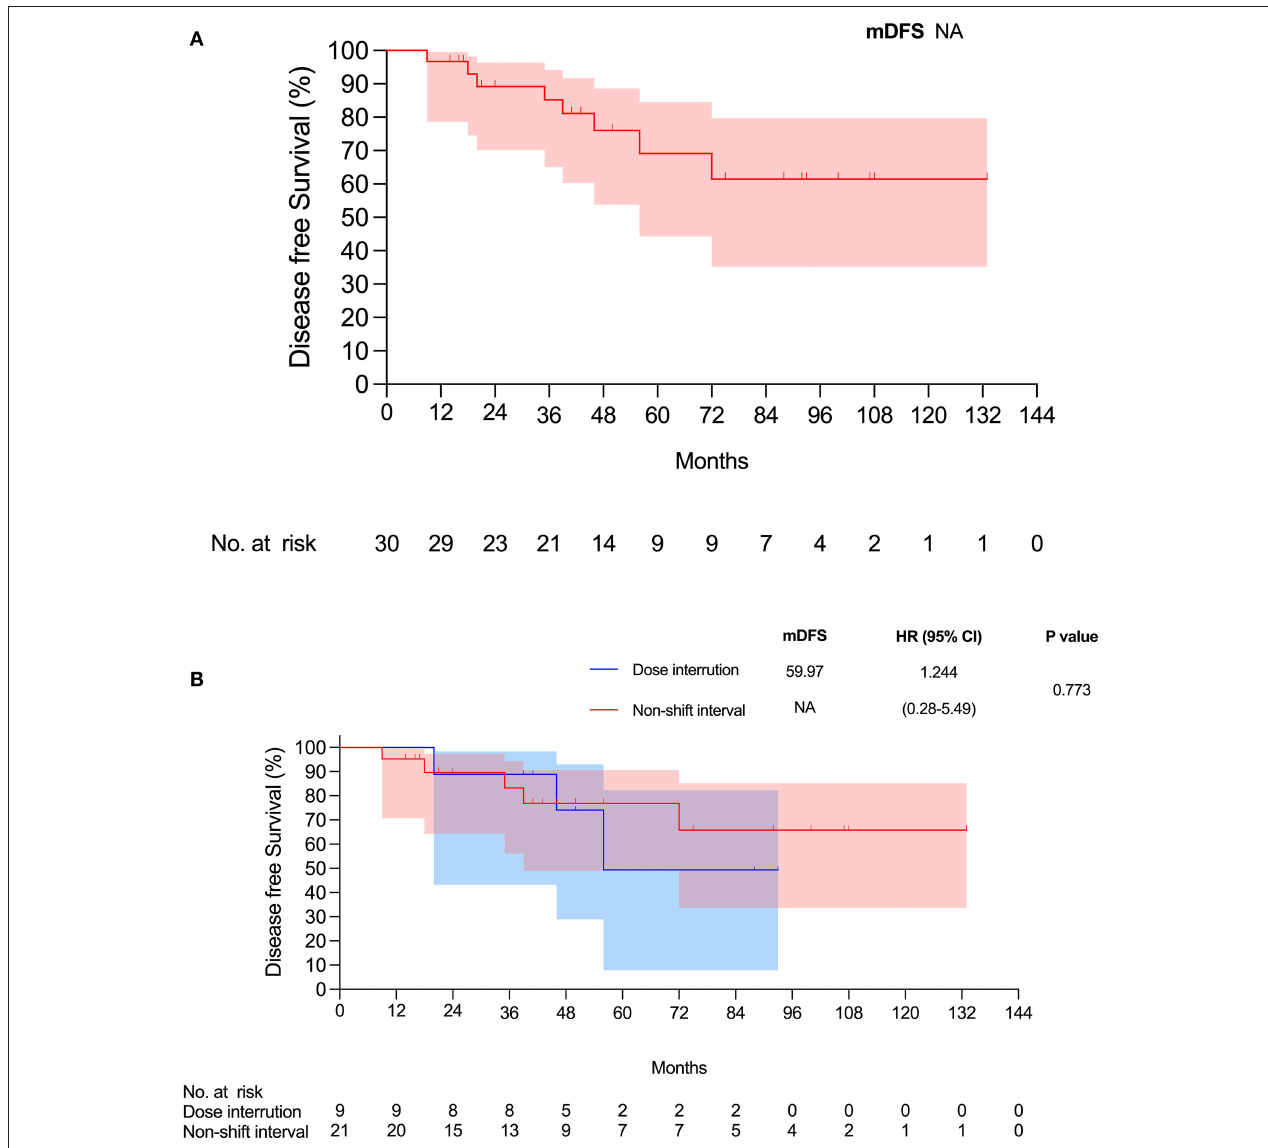
FIGURE 2 | (A) Disease-free survival for all patients. (B) Disease-free survival for two groups.